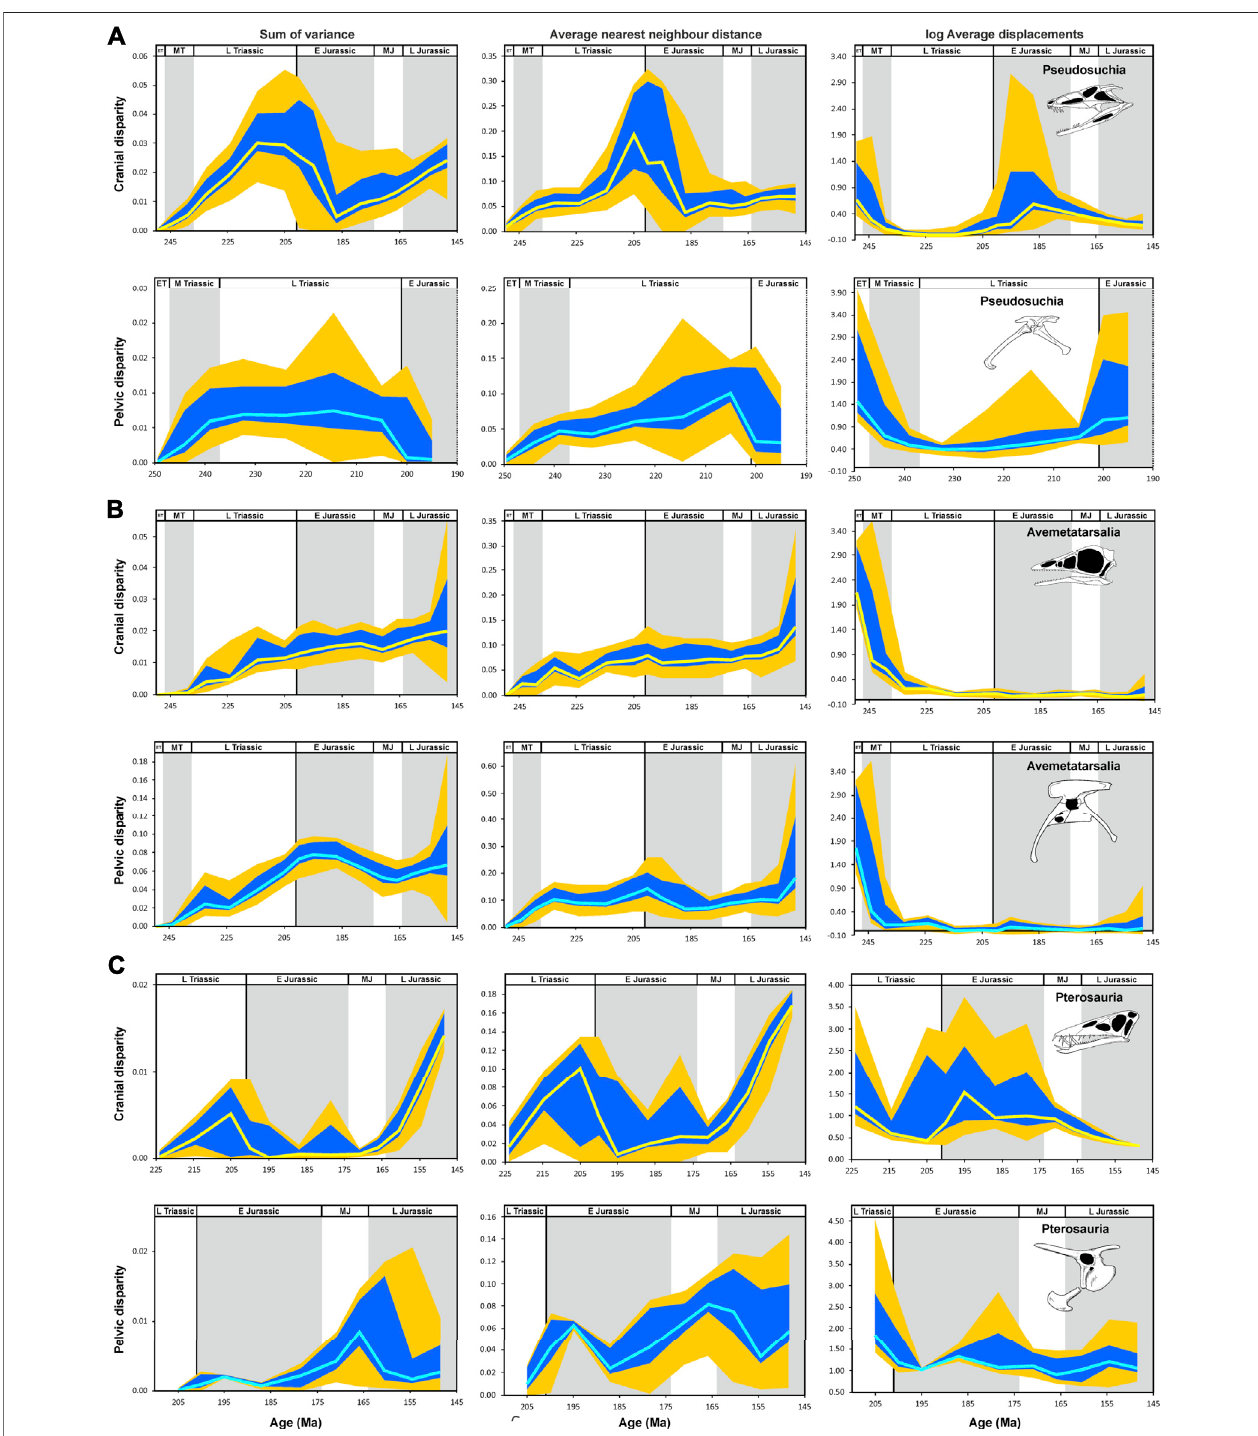
FIGURE 7 | Temporal disparity of archosauromorph cranium and pelvis captured by 2D geometric morphometrics from the late Permian to the Late Jurassic, as measured from phylogenetically interpolated values ( “ gradualistic ” model), with disparity quanti fi ed as the sum of variances, average nearest neighbor distance and average displacements (log-transformed) based on shape variables of the principal component analysis. (A) Cranial and pelvic disparity of pseudosuchians. (B) Cranial and pelvic disparity of avemetatarsalians. (C) Cranial and pelvic disparity of pterosaurs. The yellow (cranium) and cyan (pelvis) solid lines show the median of estimated disparity for each bin, with the orange bands showing the total range of disparity estimated from 1,000 time-calibrated trees and the blue band showing the range delimited by the 2.5 and 97.5% quantiles of the same. Erpetosuchus skull (A) modi fi ed after Benton and Walker (2002); Poposaurus pelvis (A) modi fi ed after Schachner et al. (2011); Archaeopteryx skull (B) modi fi ed after Rauhut (2014); Coelophysis pelvis (B) modi fi ed after Tykoski (2005); Dorygnathus skull and pelvis (C) modi fi ed after Wellnhofer (1978). Abbreviations: P, Permian; ET, Early Triassic; MT Middle Triassic L Triassic, Late Triassic; E Jurassic, Early Jurassic; MJ, Middle Jurassic; L Jurassic, Late Jurassic ( Supplementary Material S1-Tables S4 – S6